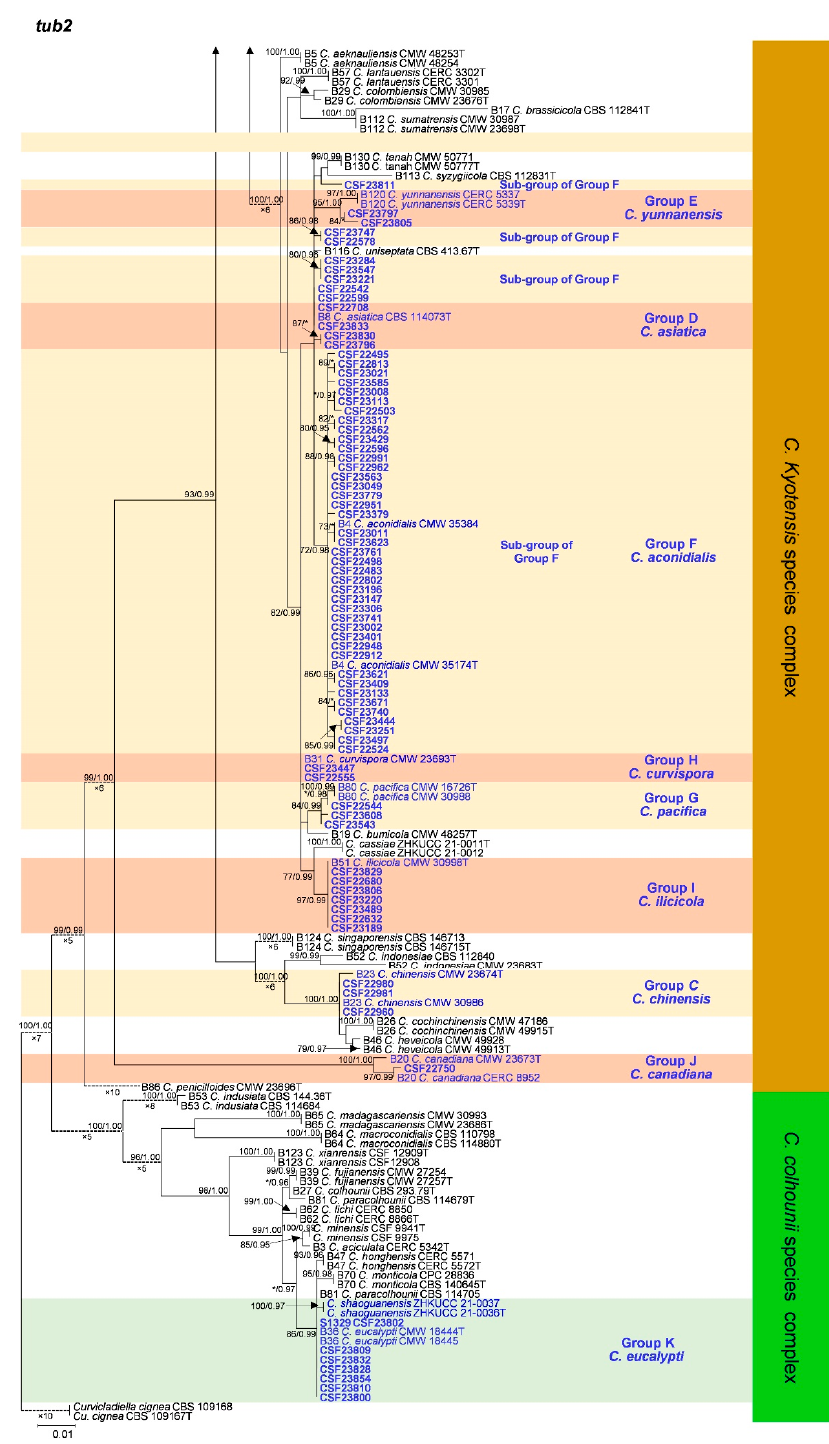
Figure A2. Phylogenetic tree of Calonectria species based on maximum likelihood (ML) analysis of the DNA dataset of the tub2 gene sequences. Bootstrap support values ≥ 70% from ML analysis and posterior probabilities values ≥ 0.95 obtained from Bayesian inference (BI) are indicated at the nodes as ML/BI. Bootstrap values < 70% or posterior probabilities values < 0.95 are marked with “*”, and absent analysis values are marked with “-”. “*/*”, “*/-”, “-/*”, and “-/-” are not displayed. Isolates obtained in this study are highlighted in blue and bold. Ex-type isolates are indicated with “T”. The “B” species codes are consistent with the recently published results of Liu and co-authors [30]. Curvicladiella cignea (CBS 109167 and CBS 109168) was used as the outgroup